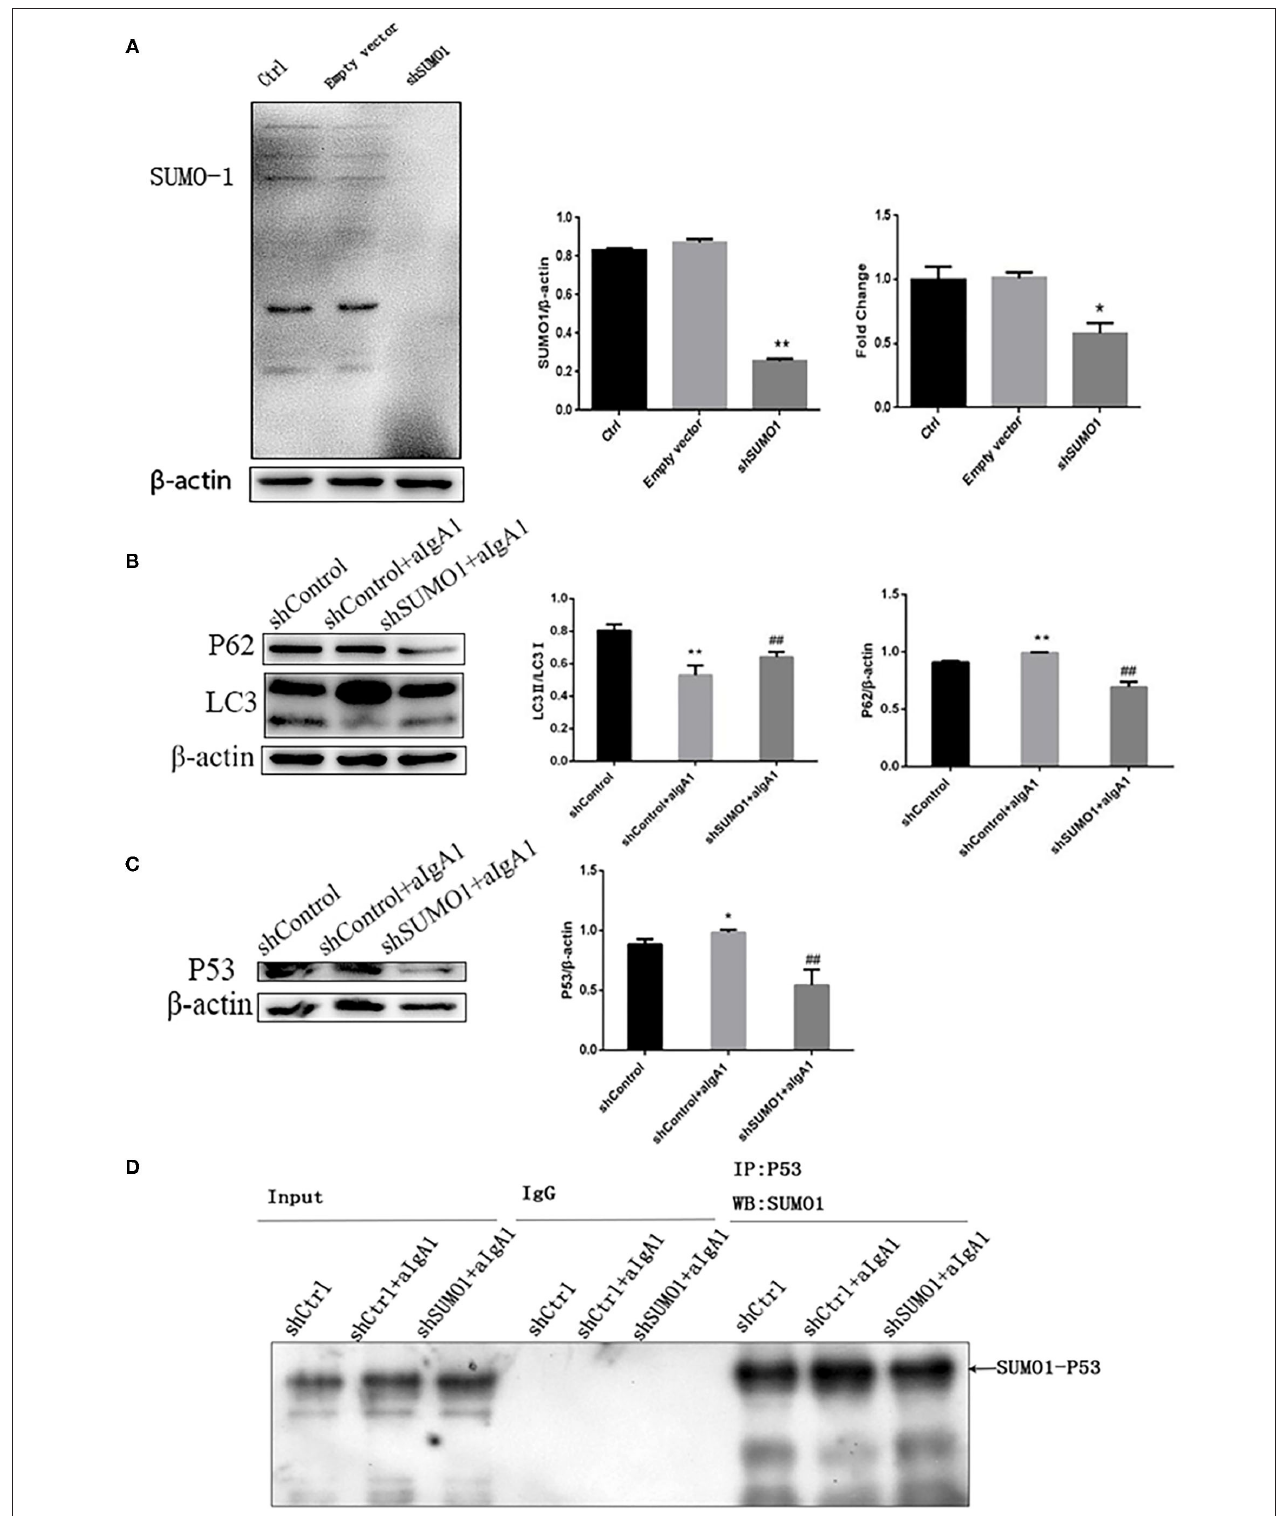
FIGURE 4 | Blockading SUMO1 in mesangial cells suppresses cell autophagy stimulated by aIgA1. (A) Western blot analysis and Real-time PCR analysis for SUMO1 in mesangial cells transfected by silencing SUMO1 plasmid. B Western blot analysis for LC3II/I, p62, and p53 in mesangial cells transfected by silencing SUMO1 plasmid. (C) Western blot analysis for p53. (D) Immunoprecipitation for SUMO1-p53 in mesangial cells. Data were presented as mean ± SD ( n = 10). * p < 0.05 vs. control, ** p < 0.01 vs. control, ## p < 0.01 vs. shControl + aIgA1 group.